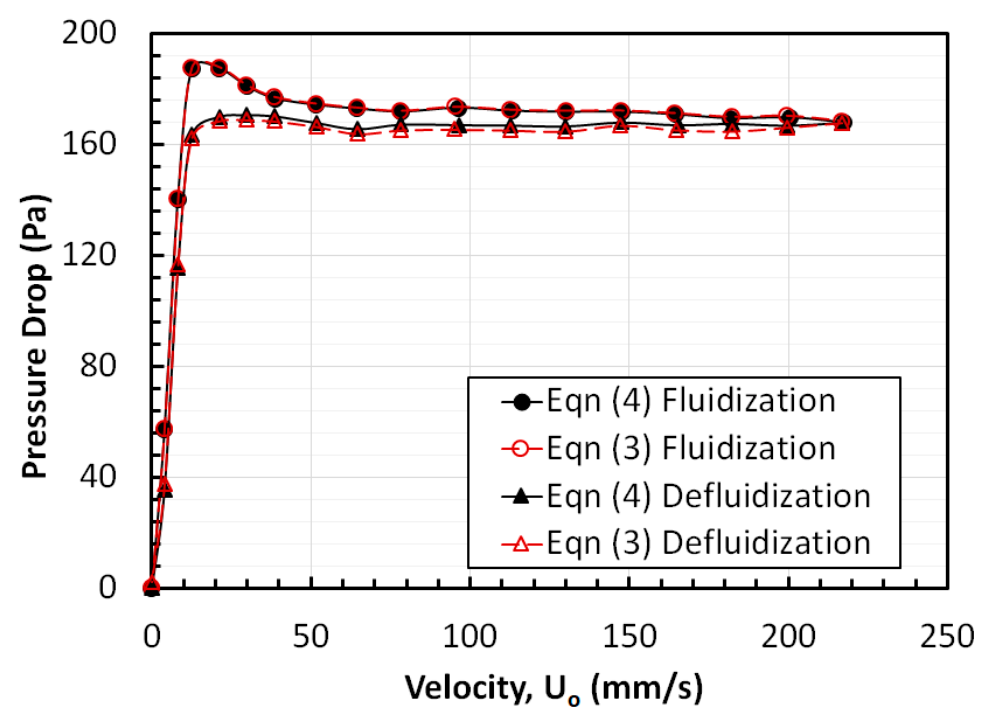
Figure 4. Comparison of pressure drops measurement using local and global pressure drops.